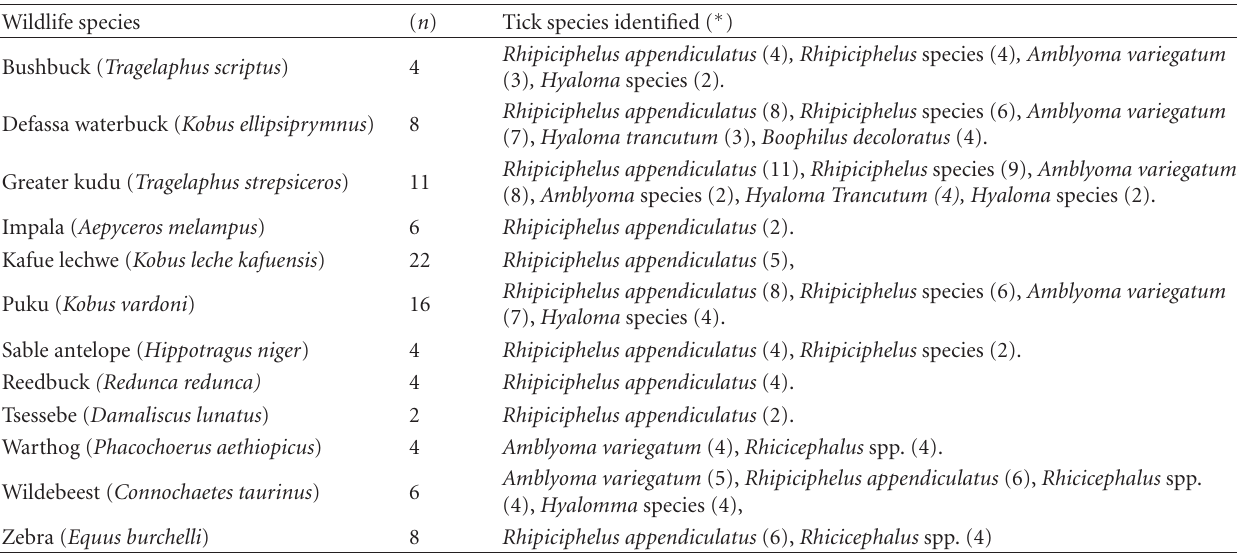
Table 3: Ticks collected from di ff erent wildlife species on game ranch.